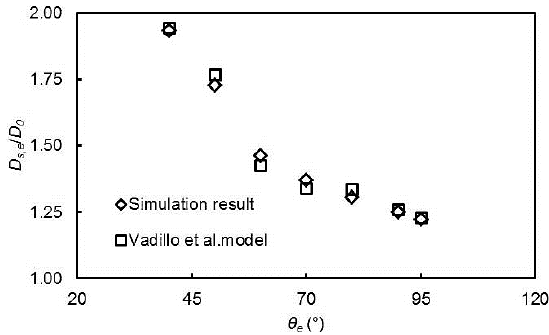
Figure 5. Comparison of the simulation result and the prediction model of Vadillo et al.